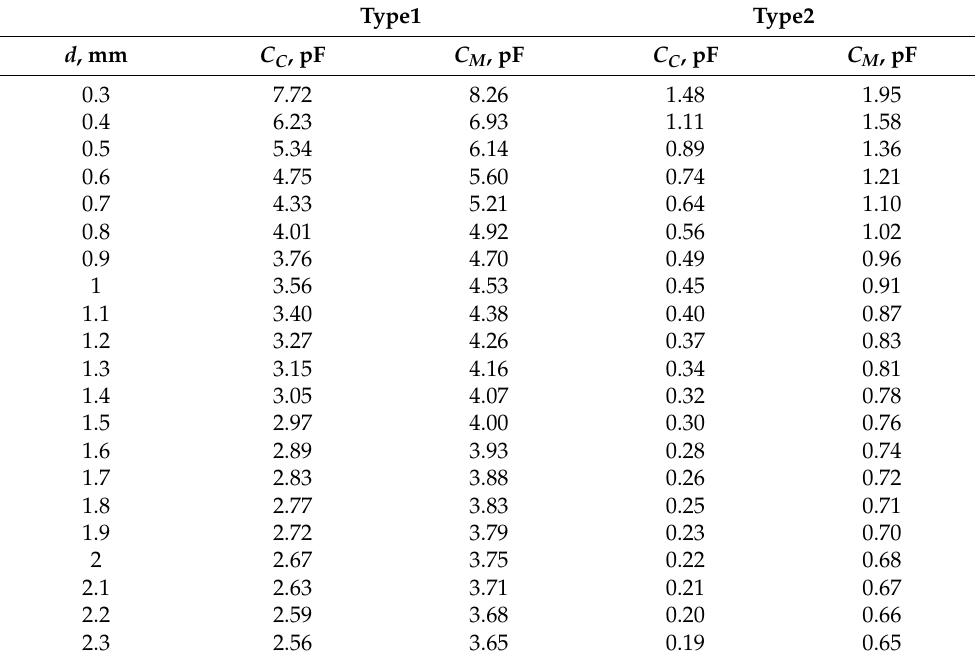
Table 1. The calculations result in the difference between response function capacities determined analytically and using computer